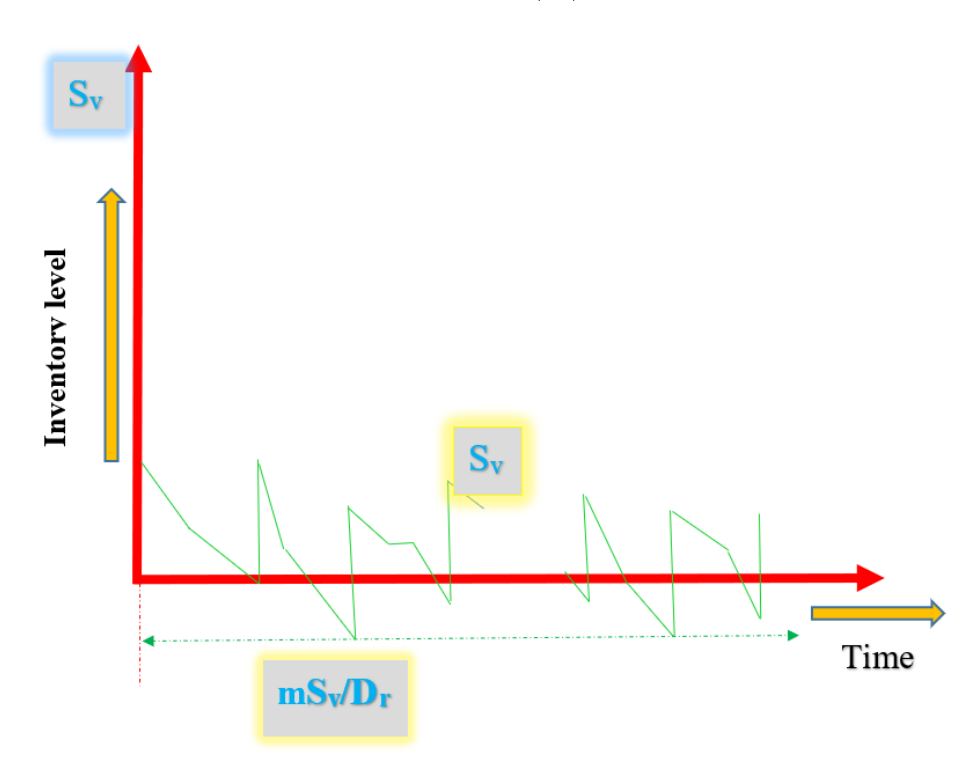
Figure 1. Inventory level for the